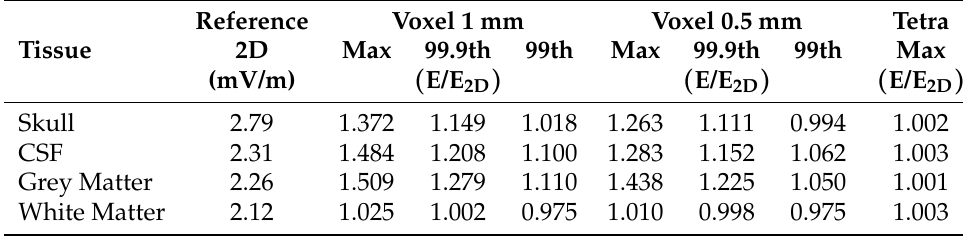
Table 3. Deviation of the E -field in the axisymmetric case.